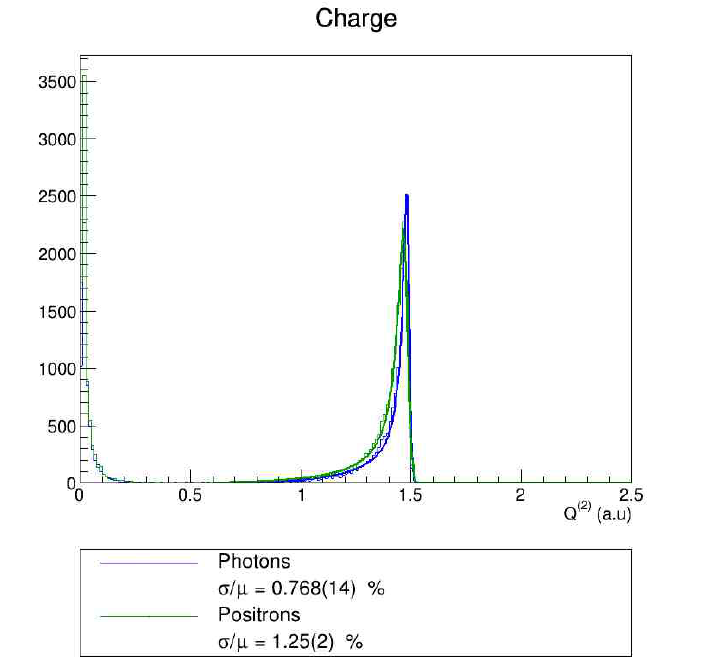
Figure 6. Corrected charge reconstruction for photons and positrons of 55MeV. The relative resolu- tion σ / µ is obtained from a fit with a tailed Gaussian function, defined in